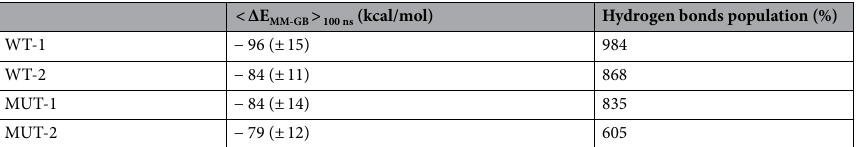
Table 1. Population of the intermolecular hydrogen bonds. The analysis was performed for the each 100 ns long trajectory (on 20–40 ns long segments, see Table S3). The hydrogen bonds population is given as a sum of all intermolecular protein–protein hydrogen bonds sampled during 100 ns long MD trajectories. The hydrogen bonds occurring < 3% in all of the sampled structures are omitted from the sum. WT wild type AR, MUT mutated AR (T878A).